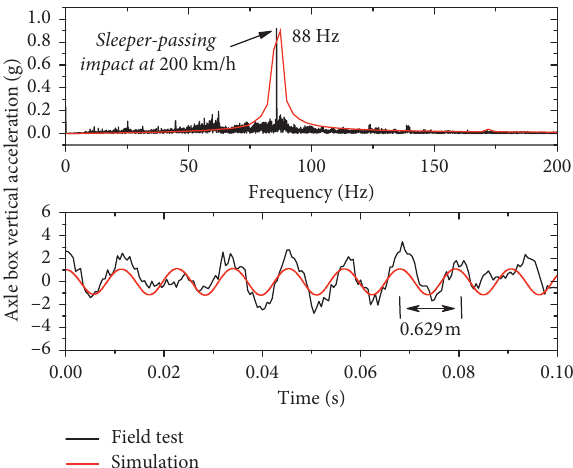
Figure 12: Comparison of the axle box vertical accelerations be- tween the simulation results and the field test measurements that were obtained in winter ( V � 200km/h and K pv �